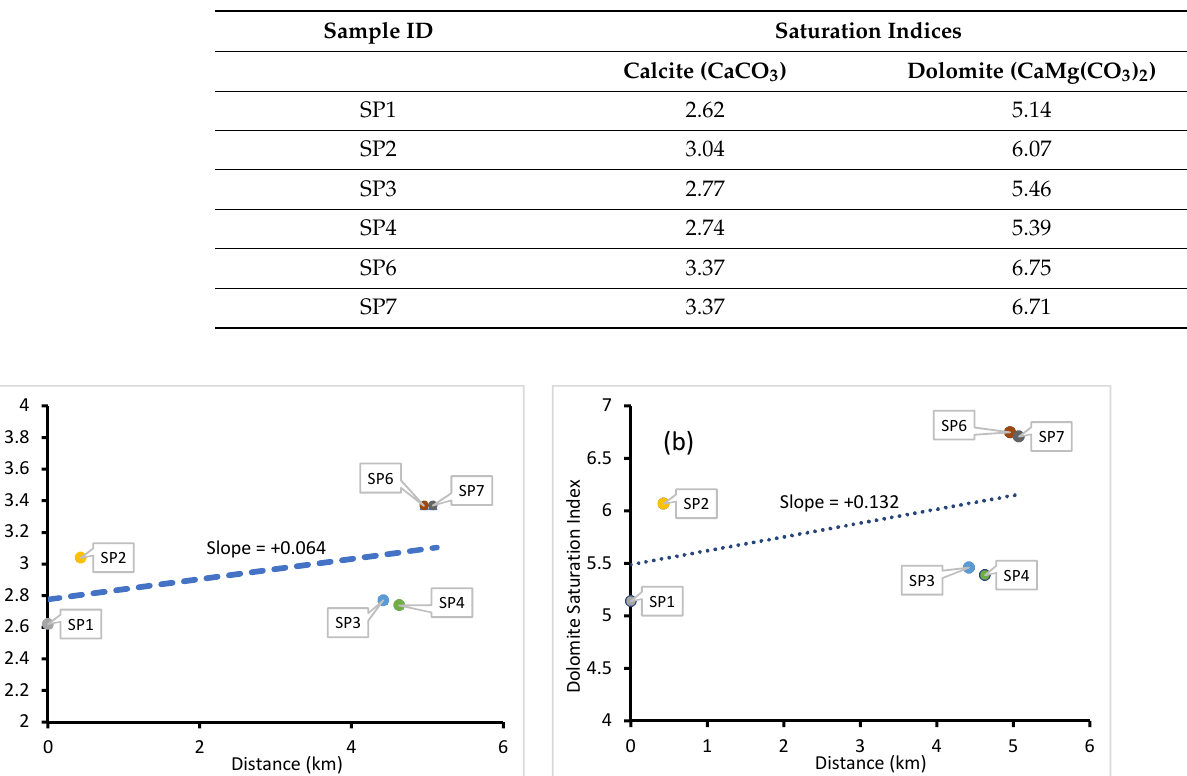
Figure 12. ORP and pH variation along the flow path showing cluster A before calcite precipitation and cluster B after calcite precipitation. Table 6. Calcite saturation indices.